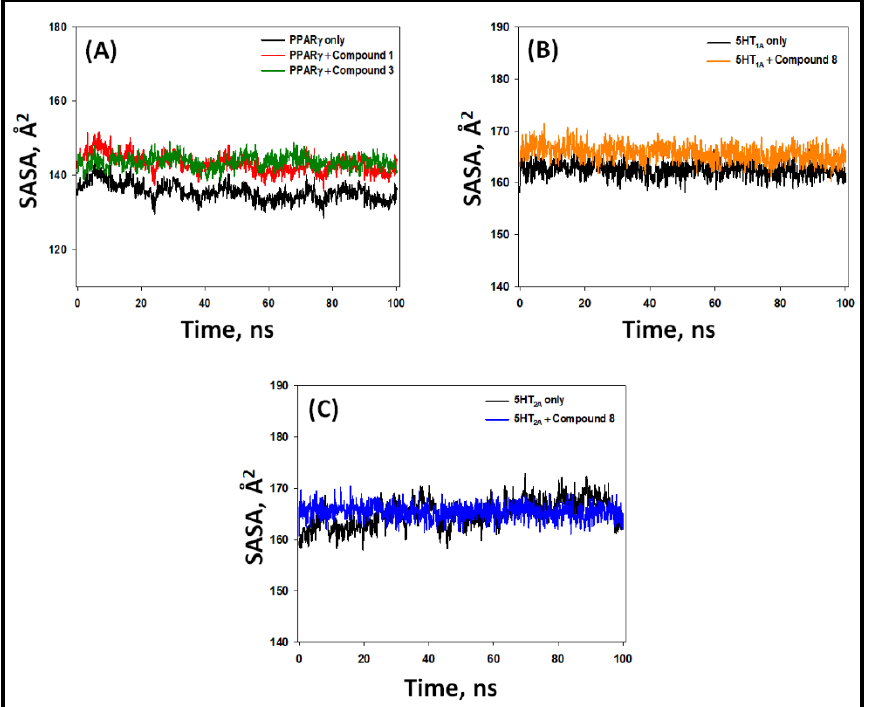
Figure 12. Variation in solvent-accessible surface area (SASA) of PPAR- γ, 5-HT 1A , and 5-HT 2A with their respective compounds. ( A ) PPAR- γ alone and in the presence of compounds 1 and 3 , ( B ) 5-HT 1A alone and in the presence of compound 8 , ( C ) 5-HT 2A alone and in the presence of compound 8.